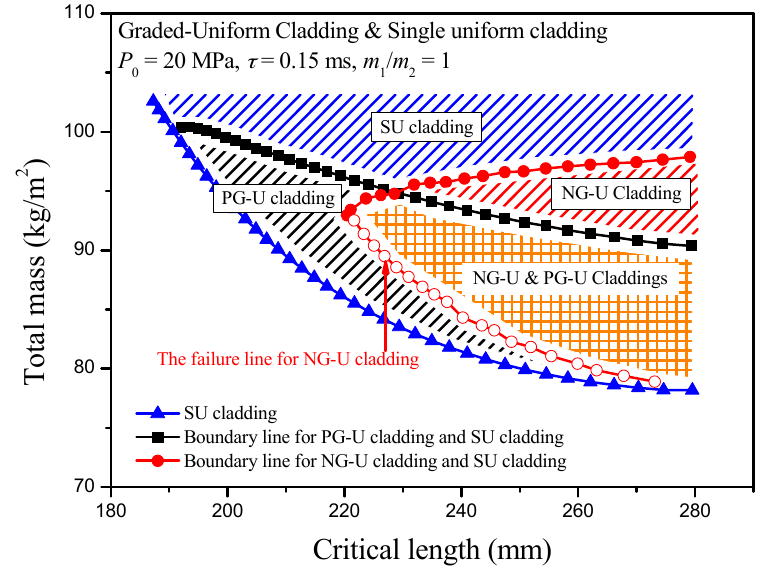
Figure 8. A partition diagram for the optimal length of sacrificial claddings.